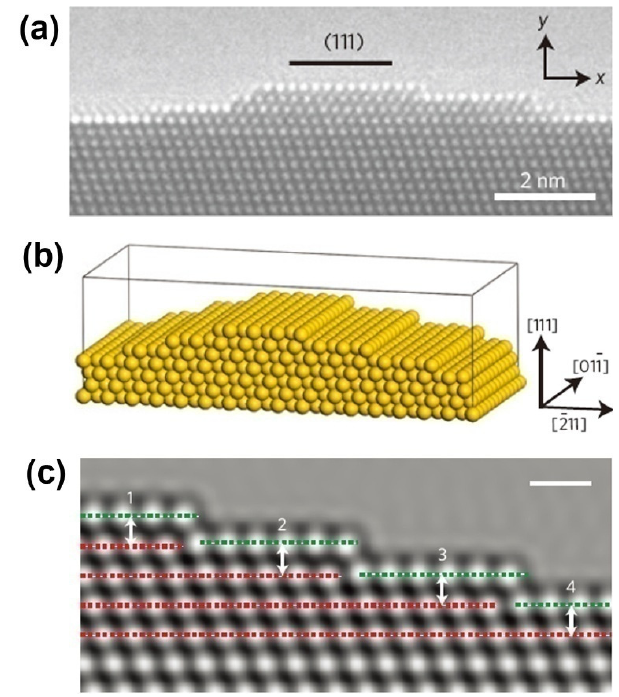
Figure 6. Characterization and simulation model of NPG surface strain: ( a ) HRTEM micrograph of a convex surface of NPG; ( b ) Structural model with a (111) surface plane; and ( c ) Simulated HRTEM image of surface configuration to evaluate the surface